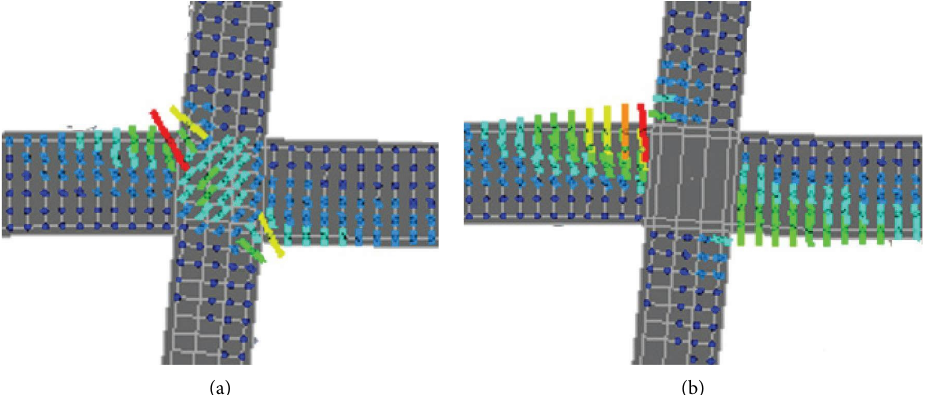
Figure 15: Crack distribution in structural members at the BC joint for the peak ground acceleration of record ID: 5 ( t � 3.01sec). (a) Frame PF4: interior joint at 3FL level. (b) Frame PF4-R: interior joint at 3FL level.